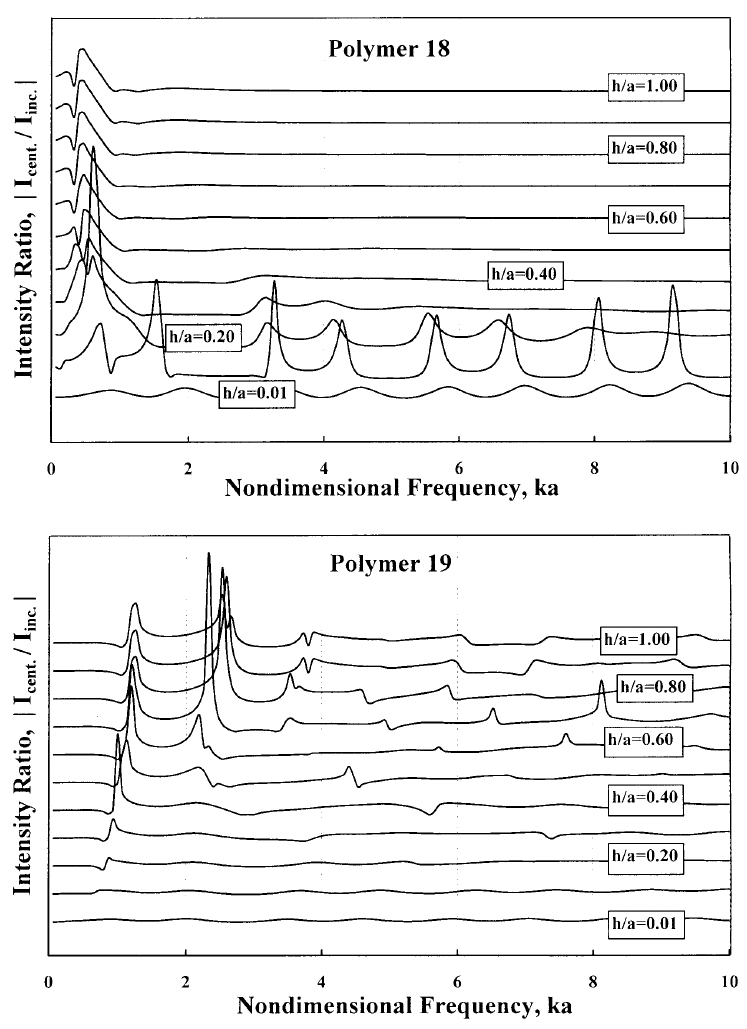
Fig. 4. Variation of Transmitted acoustic intensity per unit incident wave intensity at the center of the fluid-filled spherical viscoelastic shell with the shell thickness. ∞ (cid:7) σ 1 = rz n